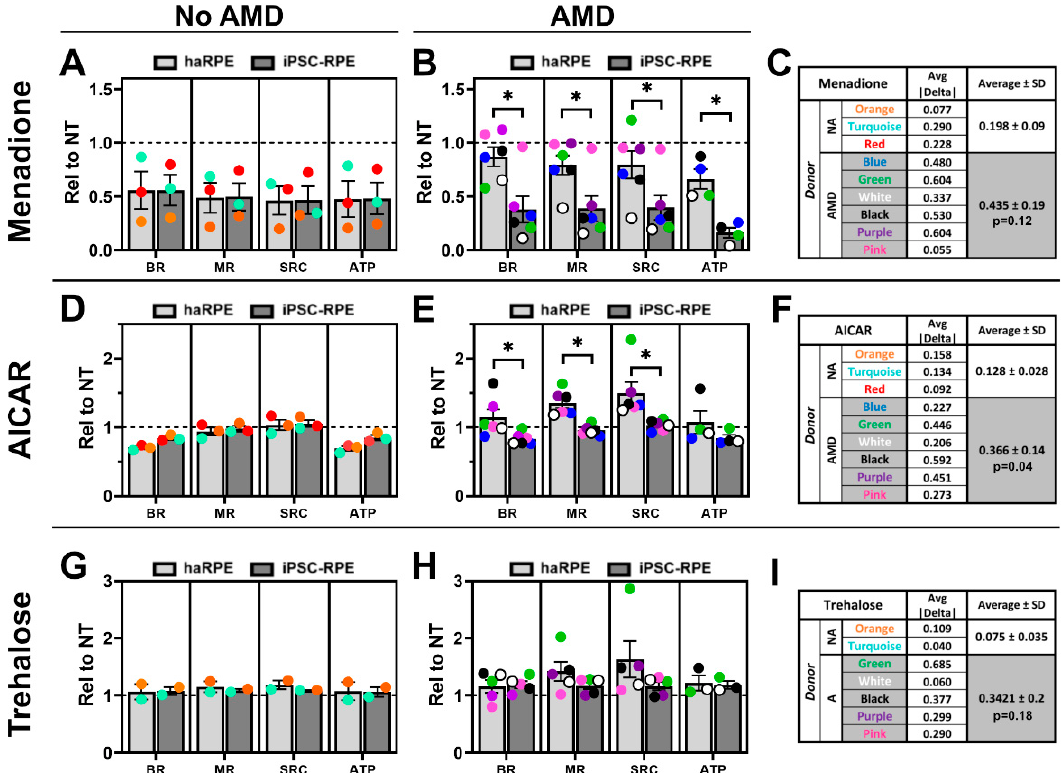
Figure 5. Comparison of haRPE and iPSC-RPE from the same donor. ( A , D , G ) Functional parameters calculated from OCR of paired cells from No AMD donors after treatment with menadione ( A ), AICAR ( D ), and trehalose ( G ). ( B , E , H ) Functional parameters calculated from OCR of paired cells from AMD donors after treatment with menadione ( B ), AICAR ( E ) and trehalose ( H ). Results were compared using a paired t -test. * denotes p < 0.05. ( C , F , I ) Summary of differences between haRPE and iPSC-RPE pairs across all four functional parameters. The average of the absolute value of the difference (|haRPE–iPSC-RPE|) for each parameter and the average for No AMD (NA) and AMD ( A ) donors is shown. Results of a paired t-test comparing No AMD to AMD is shown below